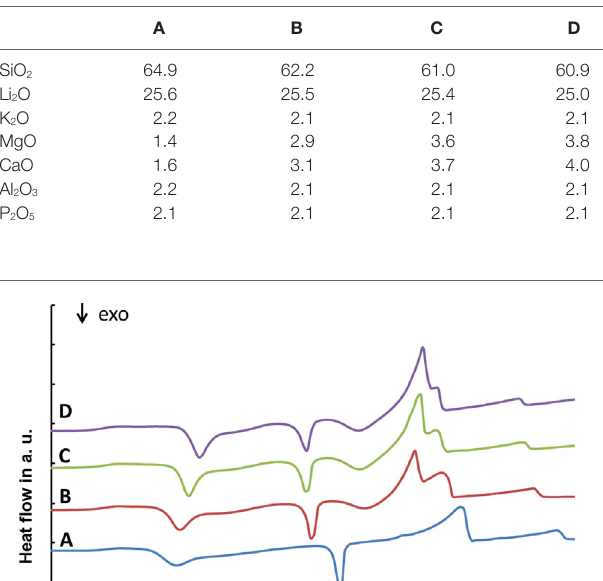
TaBle 1 | chemical compositions of the base glasses in mol% calculated from the composition determined by XrF analysis.